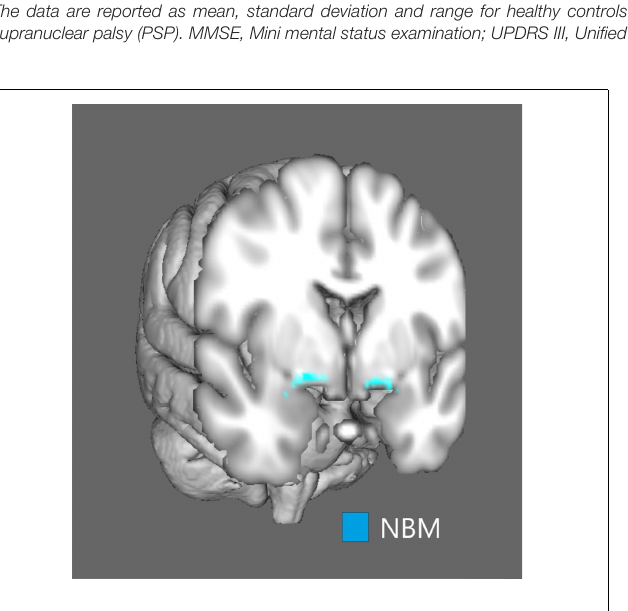
FIGURE 1 | Visual representation of the nucleus basalis of Meynert. The mask of the nucleus basalis of Meynert was overlaid on a structural MRI surface template provided by the fMRI Software Library (FSL)